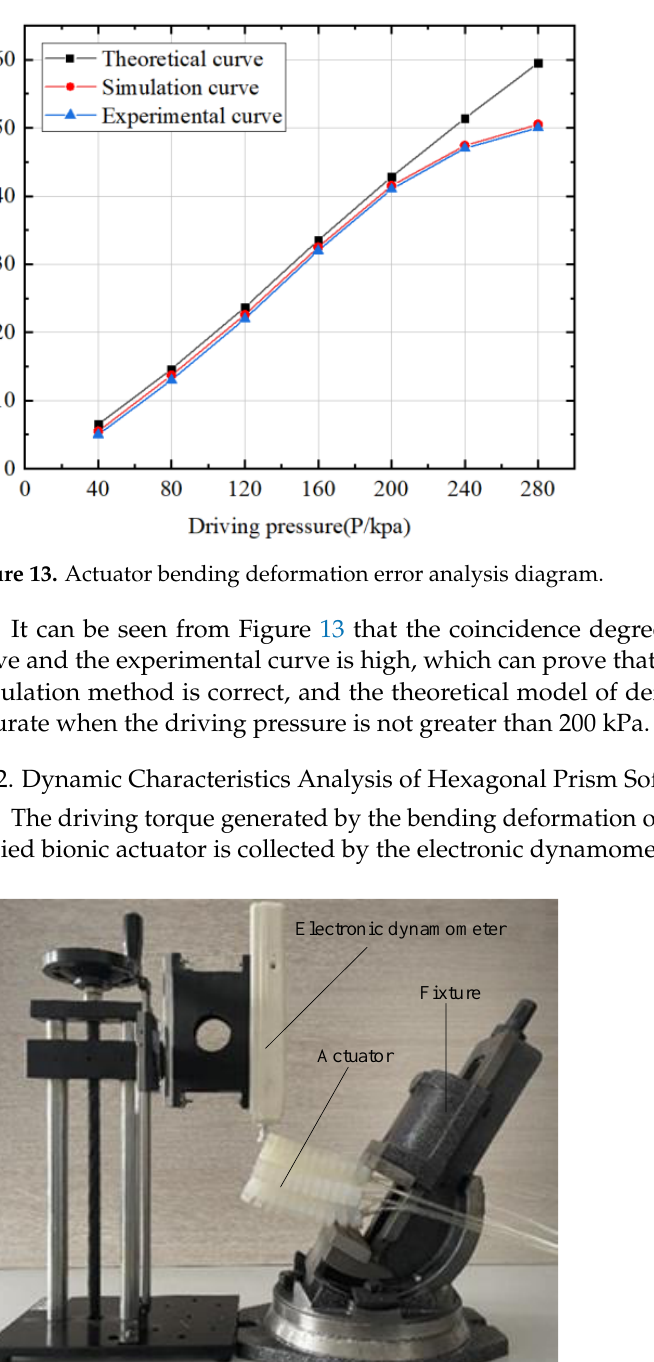
Figure 14. Driving moment measurement of hexagonal prism soft-bodied bionic actuator.